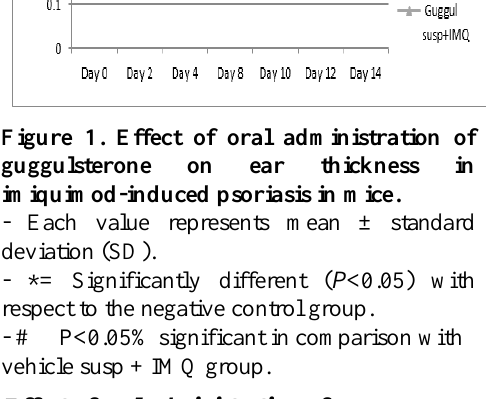
Table 1. The psoriasis area and severity index (PASI) score after oral guggulsterone administration imiquimod-induced